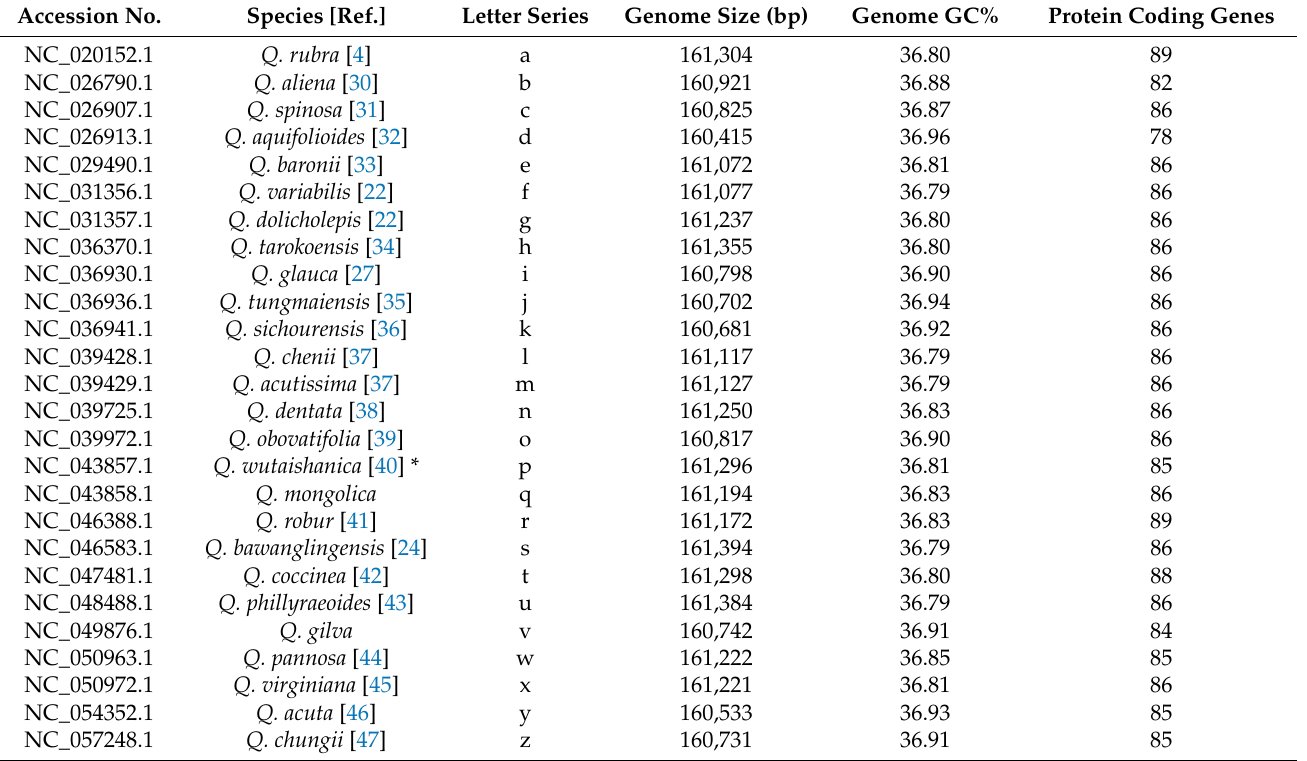
Table 1. Chloroplast genomes and their associated information of 26 Quercus